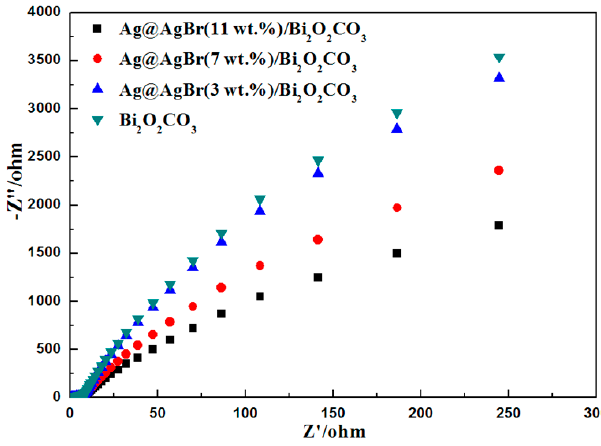
Figure 12. Nyquist plots of Bi 2 O 2 CO 3 , Ag@AgBr(3 wt %)/Bi 2 O 2 CO 3 , Ag@AgBr(7 wt %)/Bi 2 O 2 CO 3 and Ag@AgBr(11 wt %)/Bi 2 O 2 CO 3 photoelectrodes in 0.1 M Na 2 SO 4 solution (pH = 6.7).